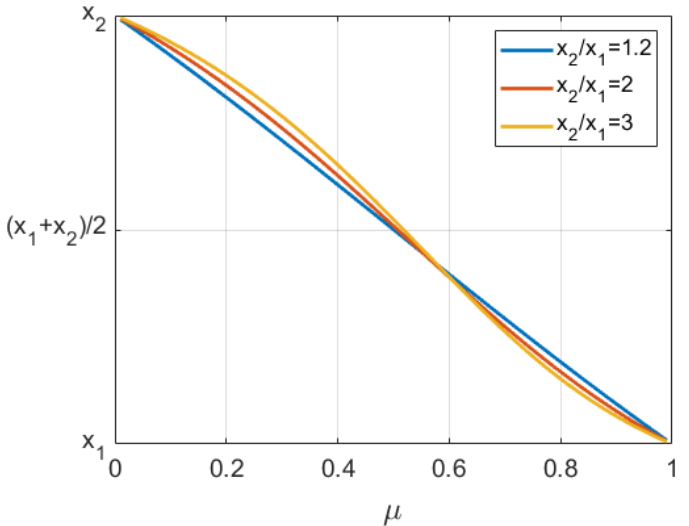
Figure 3. Location of the optimal in the sense of (11) estimate x ∗ x ∗ is shown relative to the boundary values x 1 and x 2 0